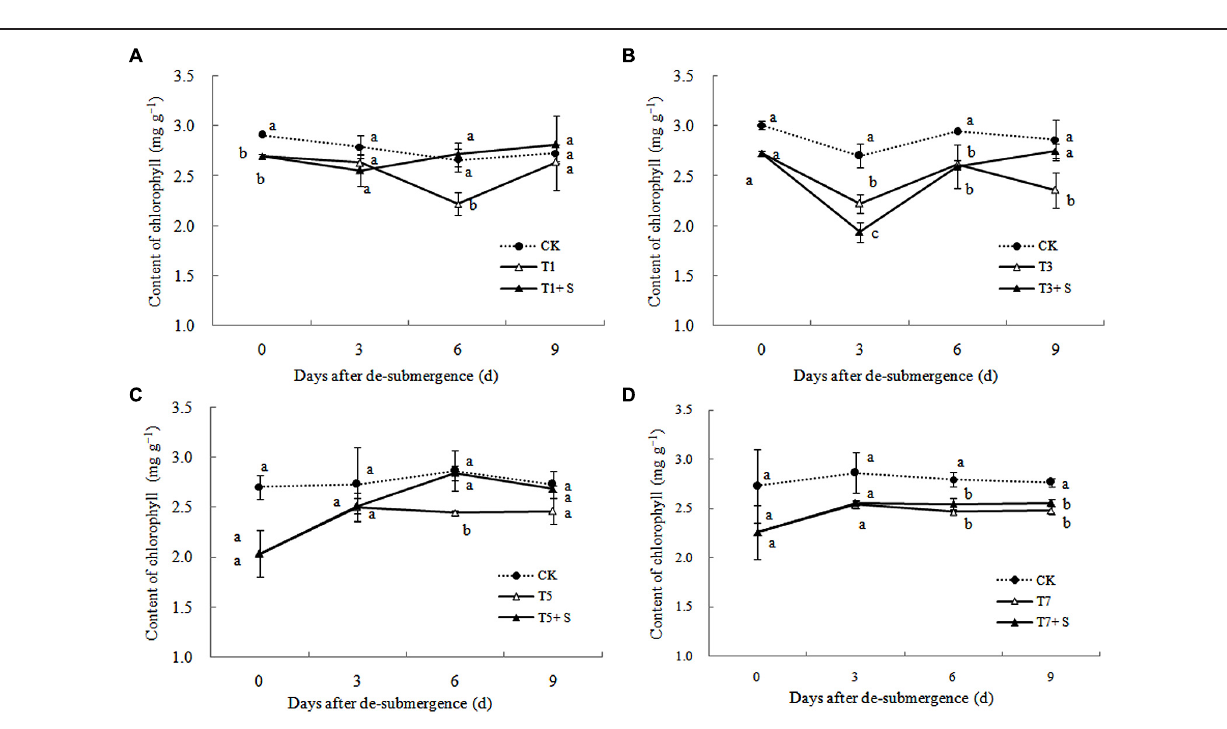
FIGURE 6 | Effects of Spd on chlorophyll content of rice after